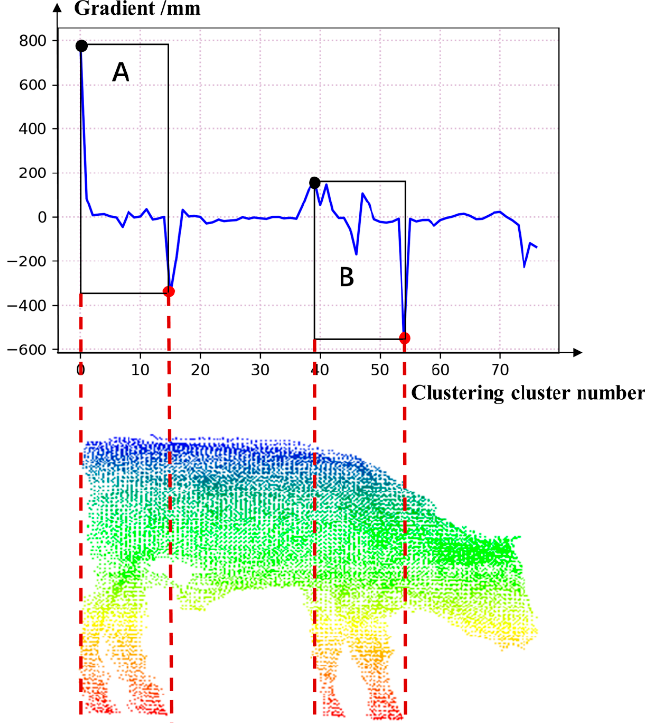
Figure 7. The gradient characteristic distribution curve of the “five-point clusters”.